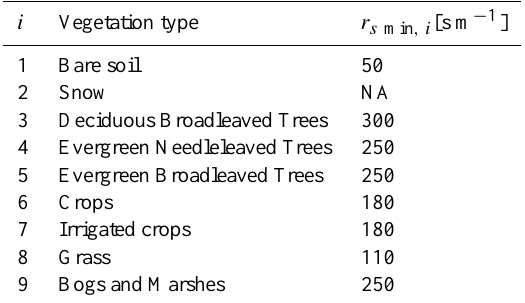
Table 1. Vegetation types and associated minimum stomatal resis- tance ( r s min , i ).